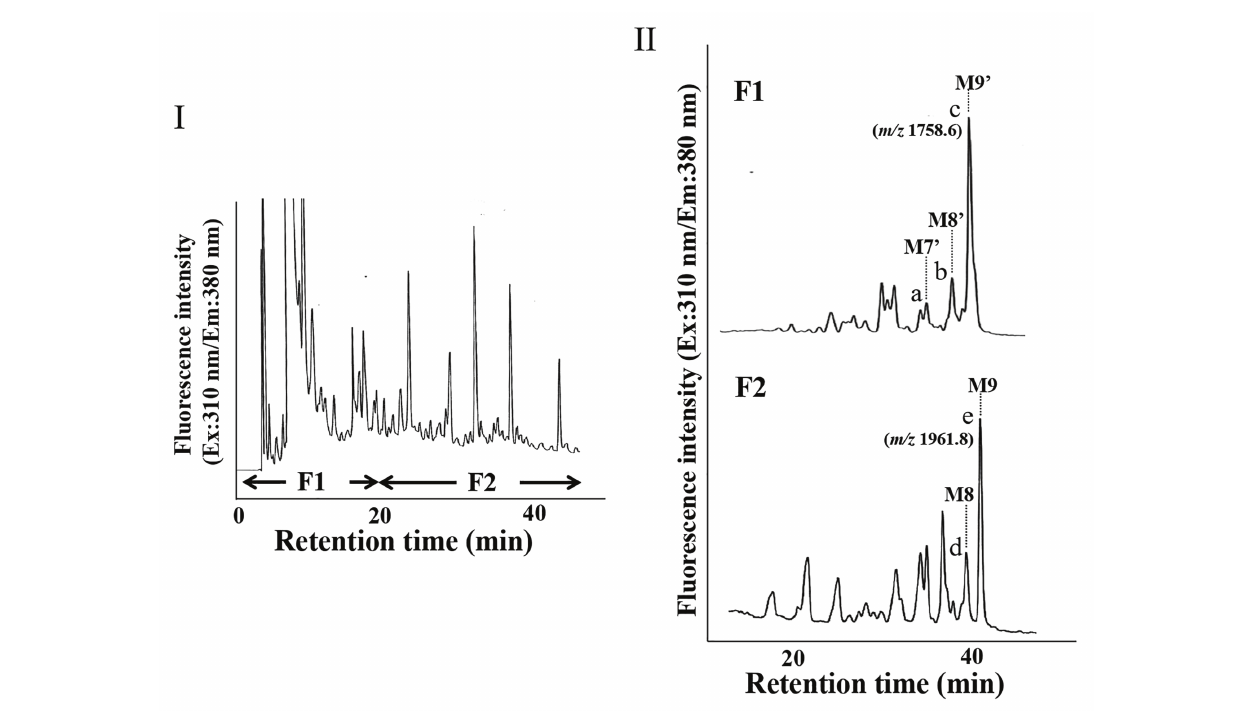
FIGURE 2 | HPLC profiles of PA-oligosaccharides obtained from pumpkin microsomes. (I) The RP-HPLC profile of crude PA-oligosaccharides obtained from pumpkin microsomes is shown. The PA-oligosaccharides were separated by RP-HPLC using a Cosmosil 5C18-AR-II column. F1 contained GN1-FNGs, whereas F2 contained GN2-FNGs. (II) The SF-HPLC profiles of F1 and F2 obtained in (I) . M9’, M8’, and M7’ indicate the elution positions of authentic PA-oligosaccharides (Man 9 GlcNAc 1 -PA, Man 8 GlcNAc 1 -PA, and Man 7 GlcNAc 1 -PA, respectively). M9 and M8 indicate the elution positions of authentic PA-oligosaccharides (Man 9 GlcNAc 2 -PA and Man 8 GlcNAc 2 -PA,